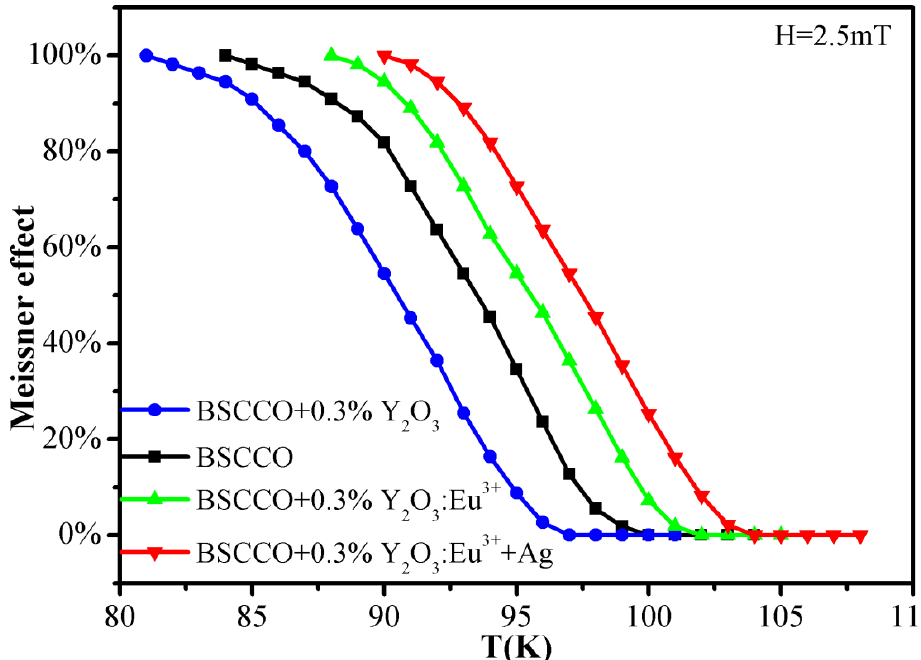
Figure 5. DC magnetization data of pure B(P)SCCO (C1) and B(P)SCCO doped with 0.3 wt% Y 2 O 3 (C3), Y 2 O 3 :Eu 3+ (C4), and Y 2 O 3 :Eu 3+ +Ag (C5).